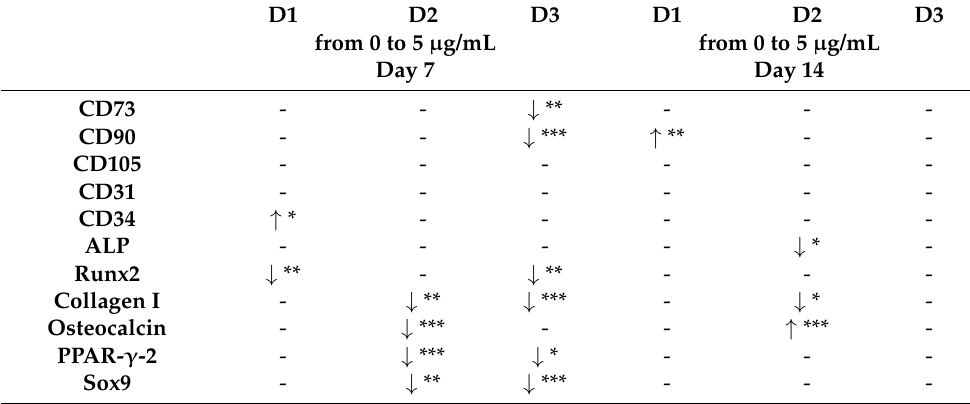
Table 1. Changes in gene expression of ASCs from three Donors (D1–D3) in the presence of 5 µ g/mL aCaP nanoparticles suspended in basal medium DMEM compared to basal medium DMEM without nanoparticles, after incubation of 7 days and 14 days, respectively. Detailed results are given in the Supporting Information Figures S1–S3. Key: ↑ = upregulation; ↓ = downregulation; * = p < 0.05; ** = p < 0.01; *** = p < 0.001; - = no significant change in gene expression. For example, ↑ * means upregulation at a significance level with p <